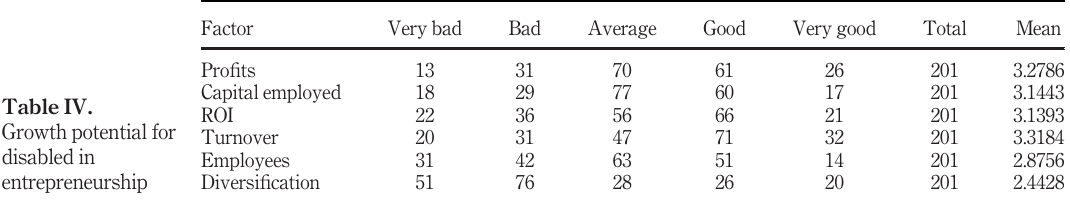
Table III. Demographic pro fi le of